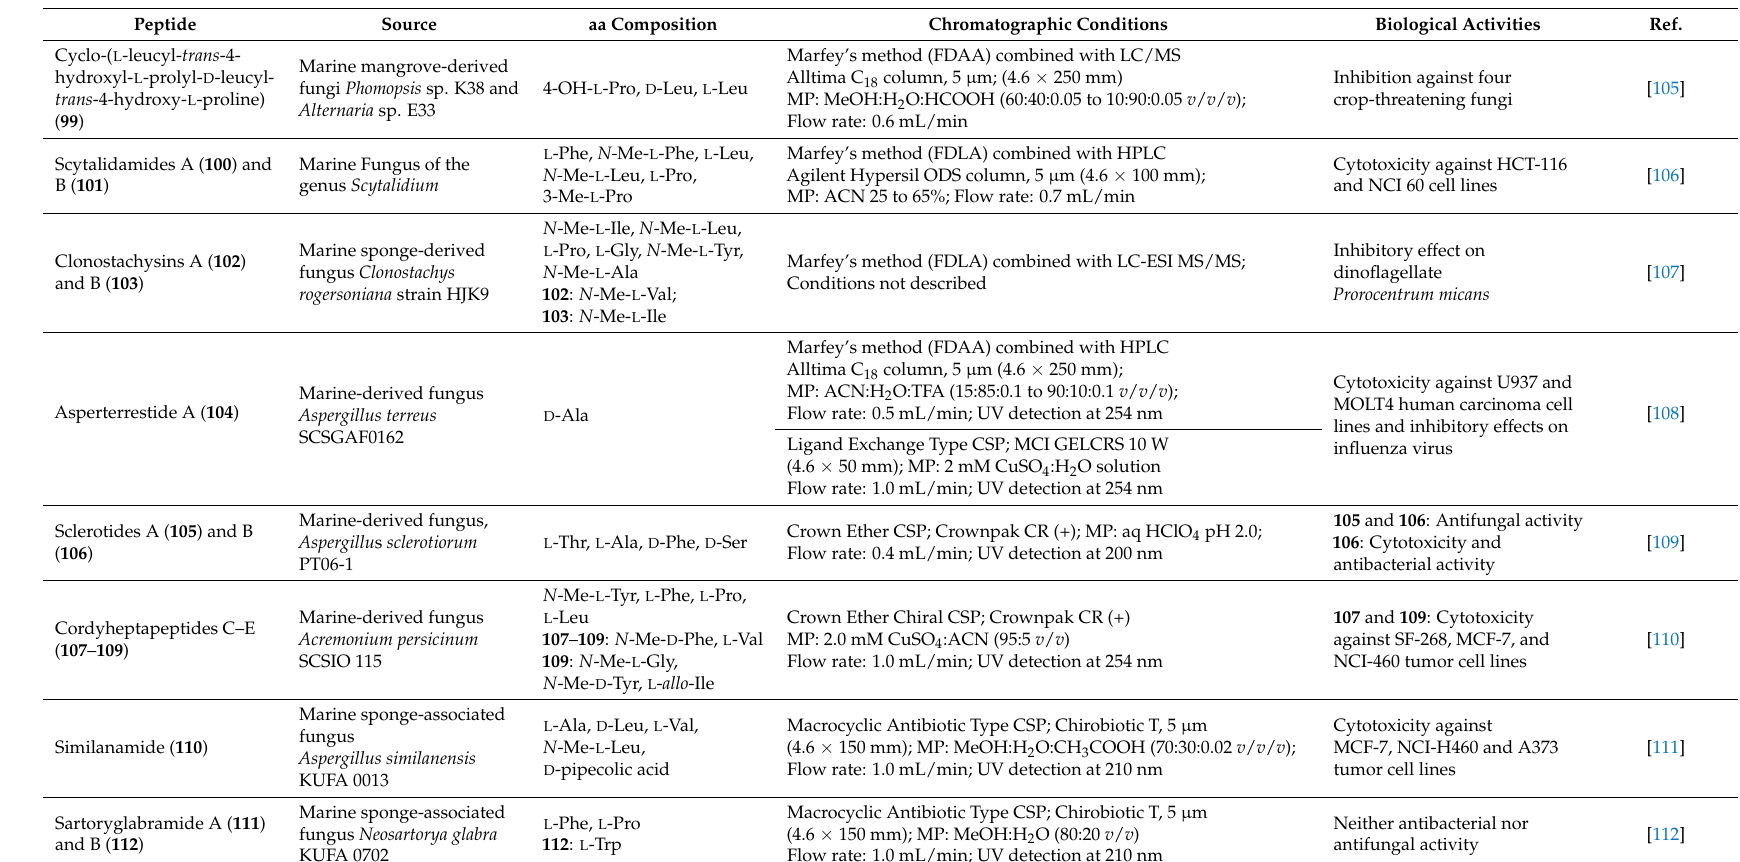
Table 4. Cyclic peptides from marine-derived